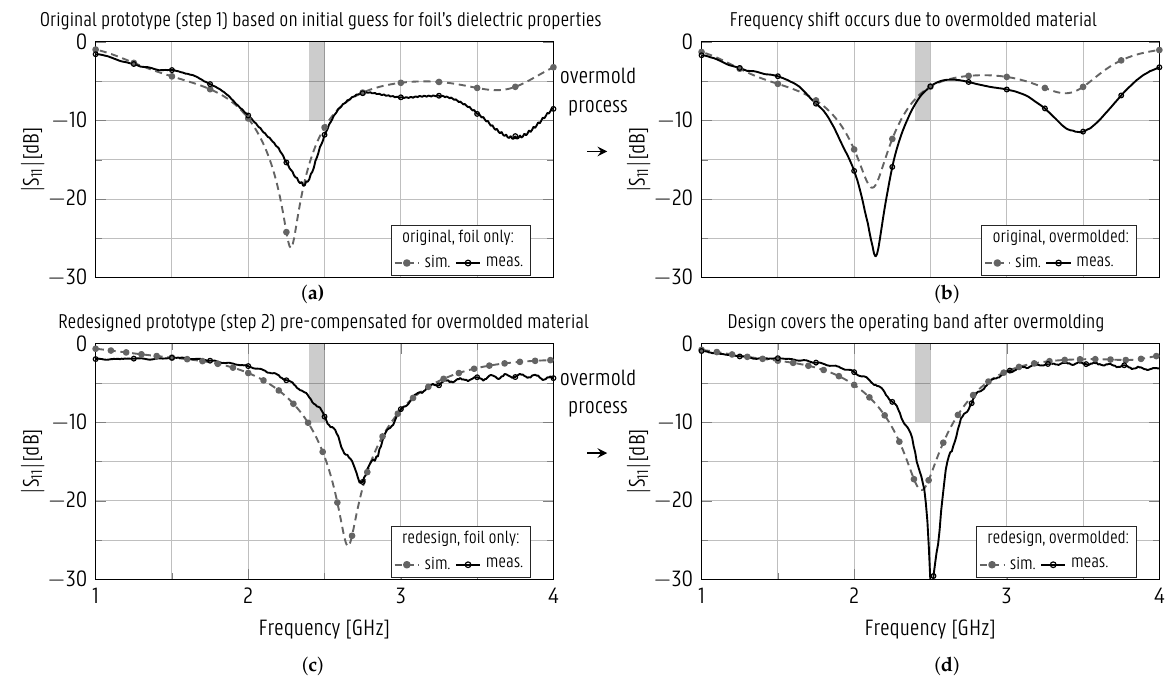
Figure 8. Simulated and measured magnitudes of the reflection coefficient of the original ( a , b ) and redesigned ( c , d ) patch antennas, both printed on plastic foil ( a , c ) and after overmolding ( b , d ). Stand-alone prototypes fed by U.FL connector (shown on the right of Figure 4).